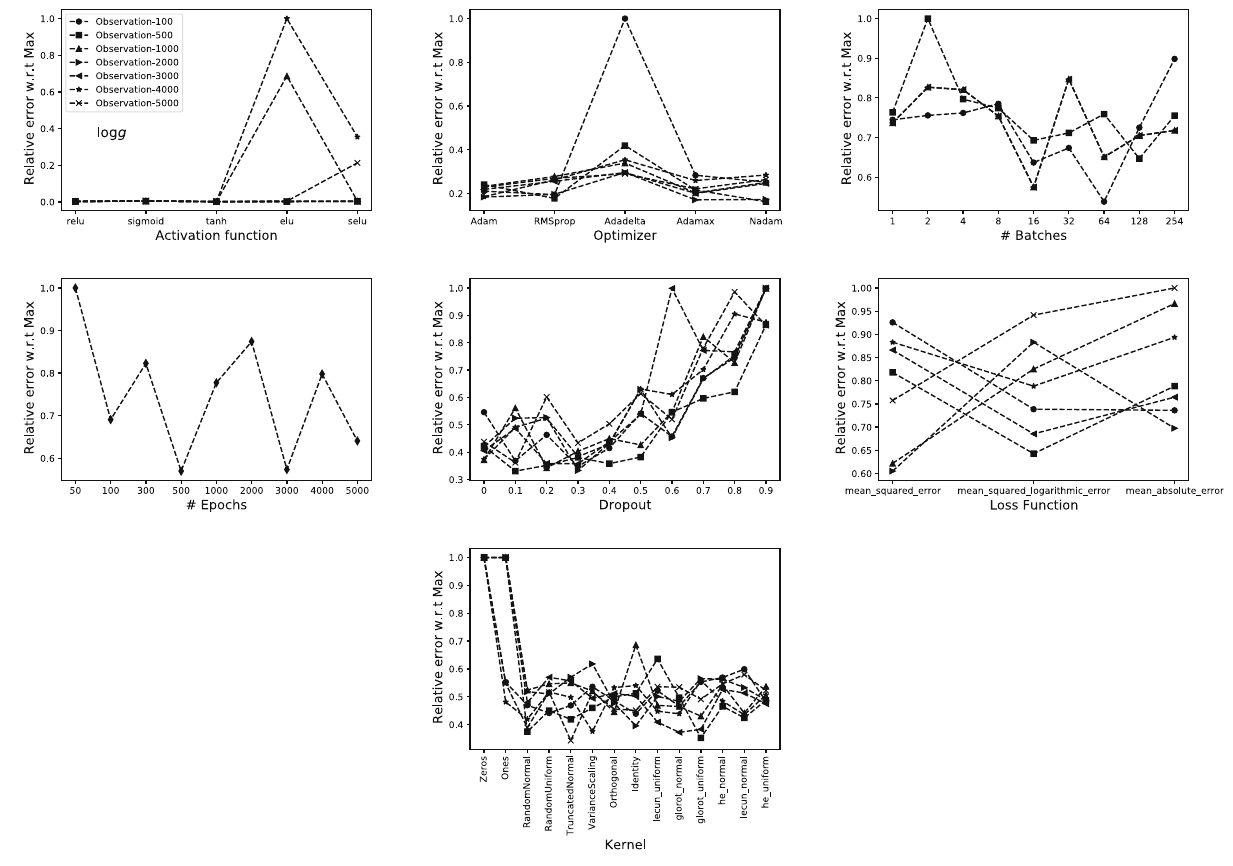
Figure 6: Same as Figure 5 but for g log